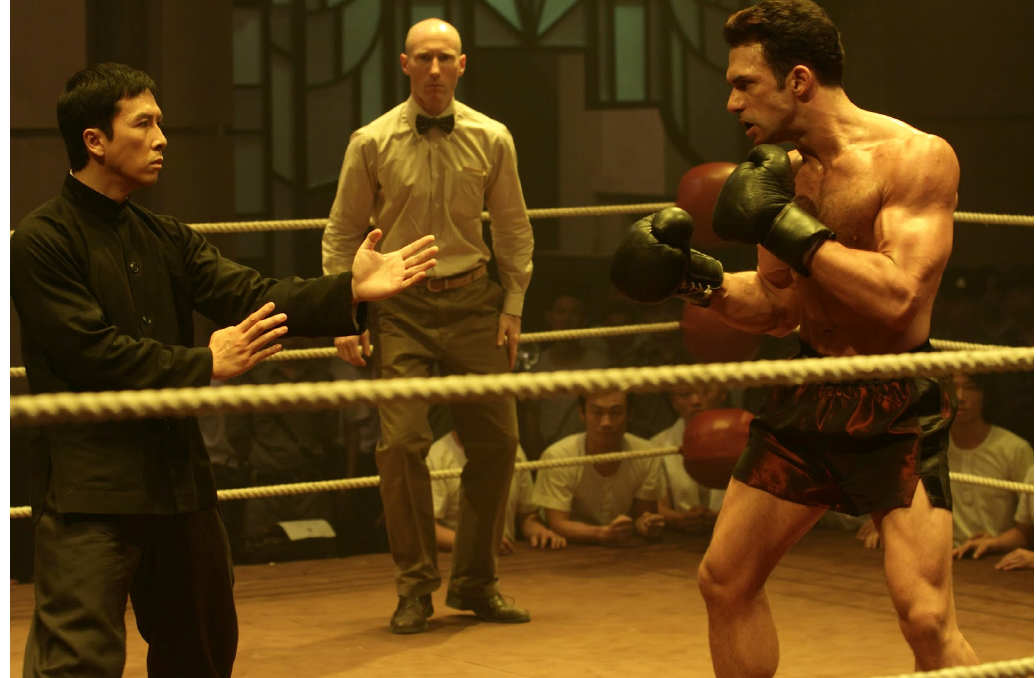
Figure 1. Ip Man vs .